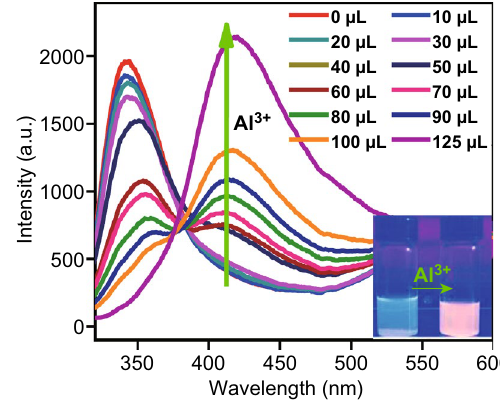
Fig. 14 Changes of emission intensities of [CuI(BPDPE)] n with incremental addition of Al 3+ (1 mM). Reproduced with permission